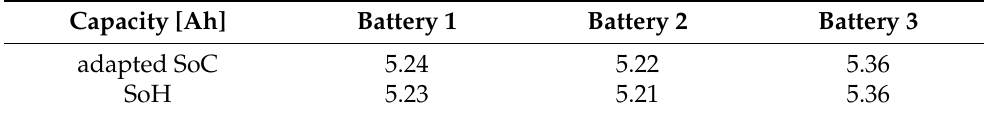
Table 5. Remaining Capacity at the end of the month of simulation: Case